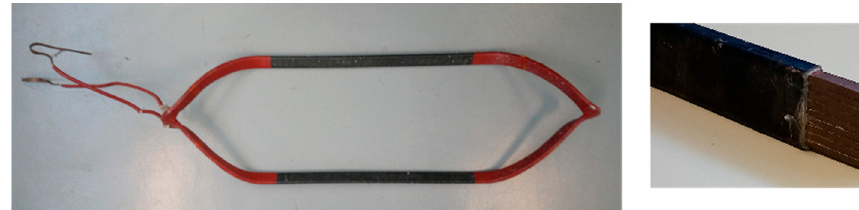
Figure 3. Bar winding.